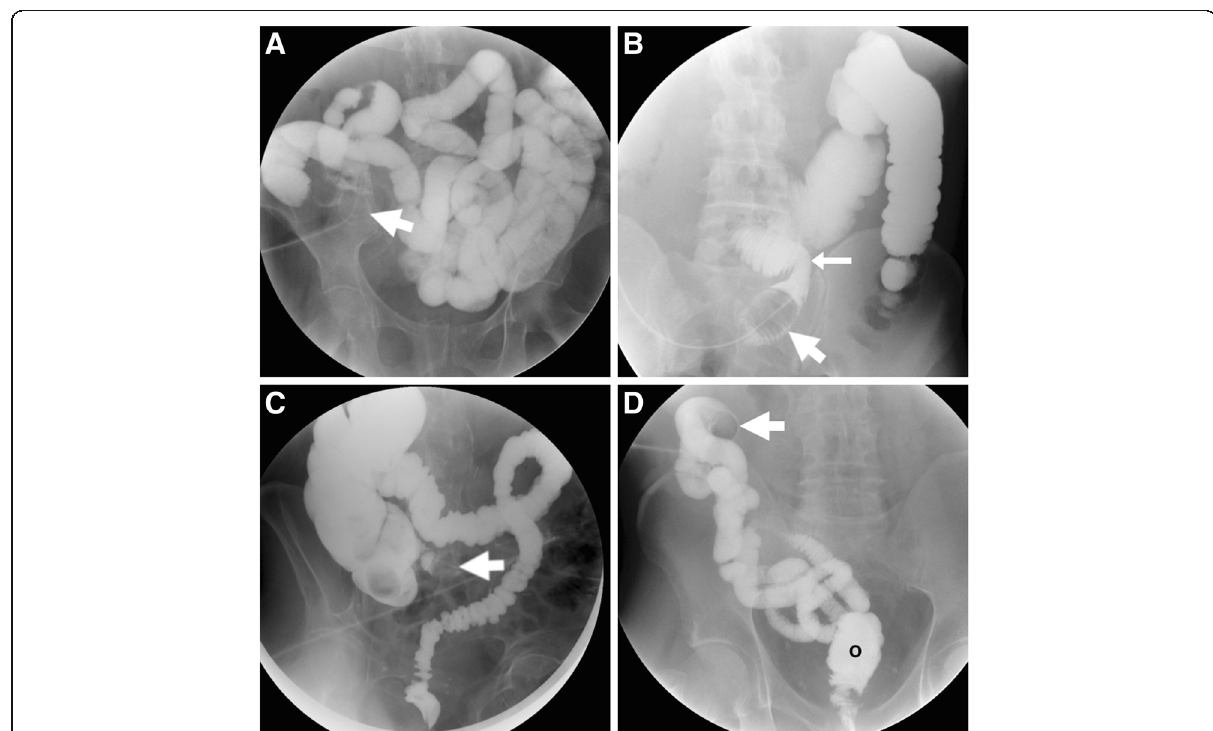
Fig. 2 Technique and normal appearances of water-soluble contrast enema (WSC-SE) using an inflated Foley catheter (thick arrows) passed through the stoma. a In a patient with long-standing Crohn ’ s disease, WSC-SE performed via end ileostomy in the right iliac fossa shows the radio-opaque diluted contrast medium filling the upstream small bowel, without signs of stricture or dilatation. b Following right colectomy, WSC-SE at defunctioning ileostomy depicts the normal termino-lateral ileo-transverse anastomosis (arrow) without anastomotic leakage. c After recent sigmoidectomy with primary anastomosis, WSC-SE shows patent residual colon up to the rectum, without extraluminal leakage. d Before planned ileostomy takedown, after restorative proctocolectomy for ulcerative colitis, WSC-SE via the efferent limb opacifies the small bowel up